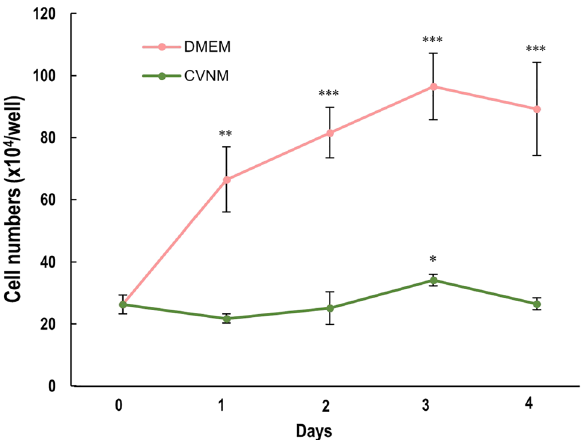
Figure 6. Numbers of RL34 cells cultured in a 24-well plate with DMEM or 15% CVNM for 4 days. Data are presented as the mean ± standard deviation (n = 3). *** P < 0.001, ** P < 0.01, * P < 0.05. CVNM, Chlorella vulgaris -derived nutrient media; DMEM, Dulbecco’s modified Eagle’s medium.